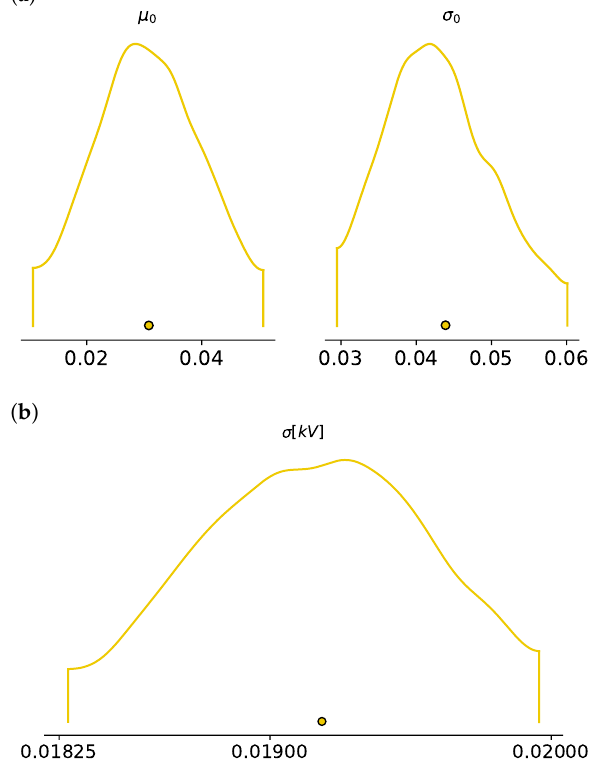
Figure 9. Kernel density estimators of ( a ) hyper-parameters µ 0 , σ 0 (which have no units) and ( b ) standard error of voltage measurement (kV) also show reasonable sampling behavior. All the distributions are reasonably